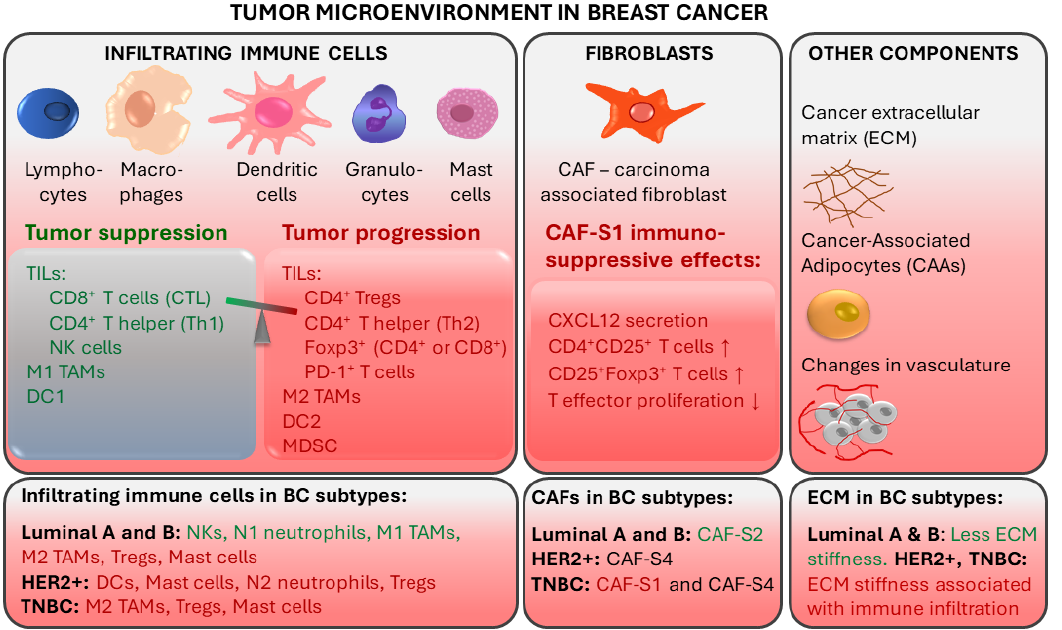
Figure 1. Tumor-associated immune responses in breast cancer. Major players in breast TME in- clude tumor-infiltrating lymphocytes (TILs) and tumor-associated macrophages (TAMs). Non-immune cells such as cancer-associated fibroblasts (CAFs) and cancer-associated adipocytes (CAAs) contribute to an immunosuppressive environment. CTL: cytotoxic CD8 + T lymphocytes; Th: CD4 + T helper cells; NK: natural killer cells; DC: Dendritic cells; Tregs: regulatory T cells; MDSCs: myeloid-derived suppressor cells. Red text color indicates tumor progression and immunosuppressive effects. Green text color indicates tumor suppression.